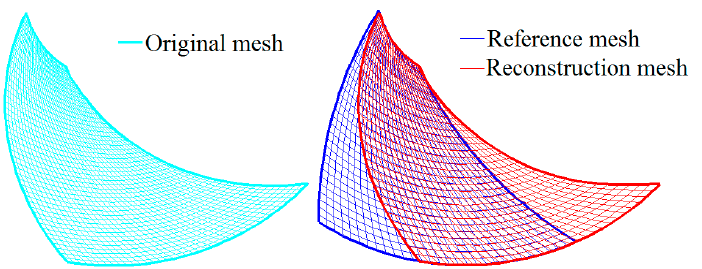
Figure 6. Schematic diagram of mesh reconstruction .